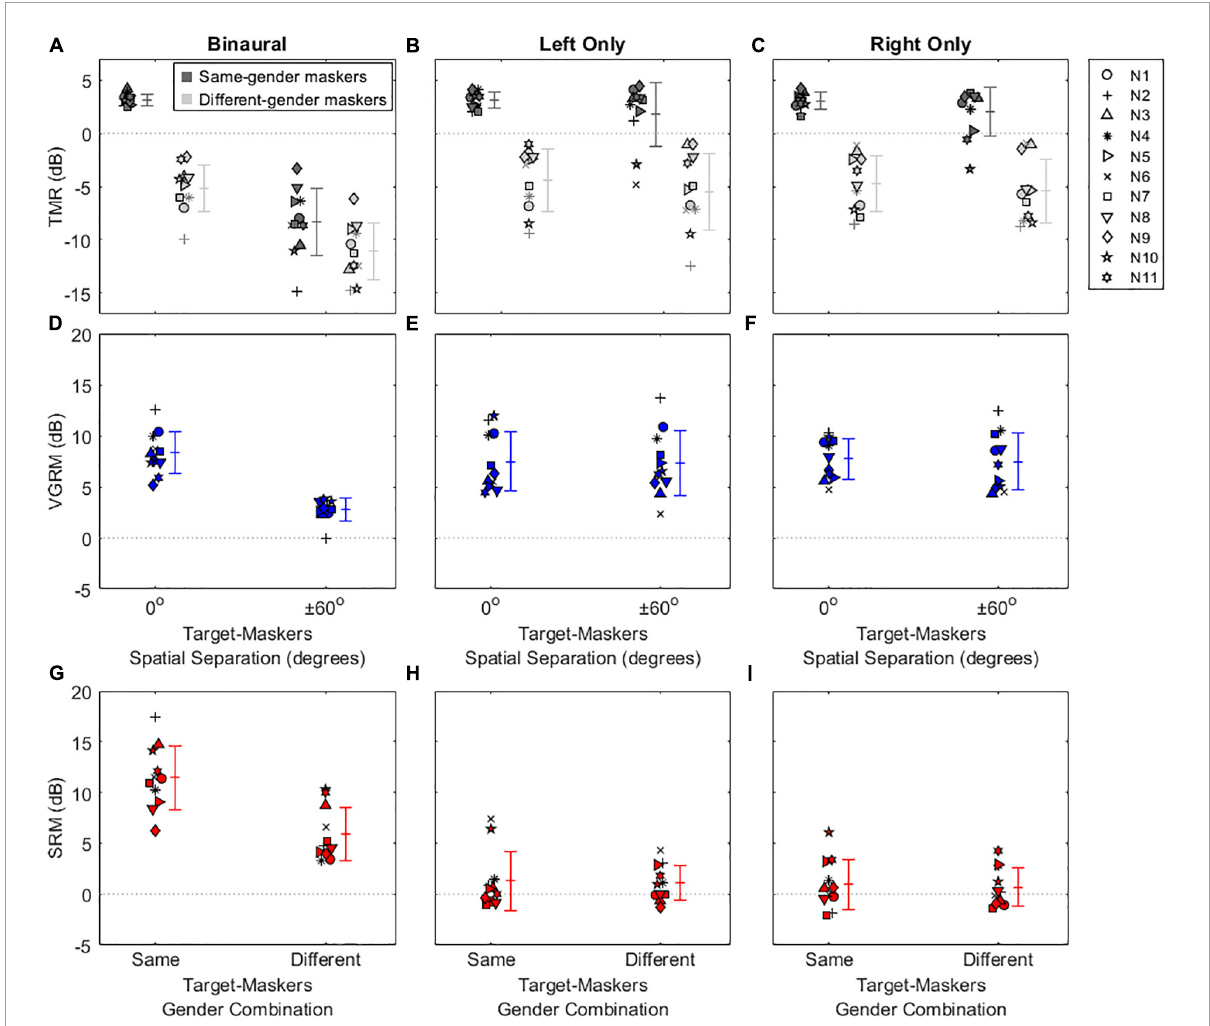
FIGURE2 Individual and average target-to-masker ratio (TMR) thresholds and voice gender release from masking (VGRM) and spatial release from masking (SRM) for NH listeners. The left, middle, and right columns refer to the binaural, left only, and right only listening conditions, respectively. The upper panels show the TMR thresholds (A–C) as a function of target-masker spatial separation (0 and ± 60 ◦ ). Dark-shaded and light-shaded symbols indicate TMR thresholds for the same-gender masker and the different-gender masker conditions, respectively. The middle panels show VGRMs (D–F) as a function of target-masker spatial separation (0 and ± 60 ◦ ). The lower panels show SRMs (G–I) as a function of target-masker gender combination (same-gender and different-gender). Error bars represent standard deviation around the mean. Horizontal dotted lines represent reference zero